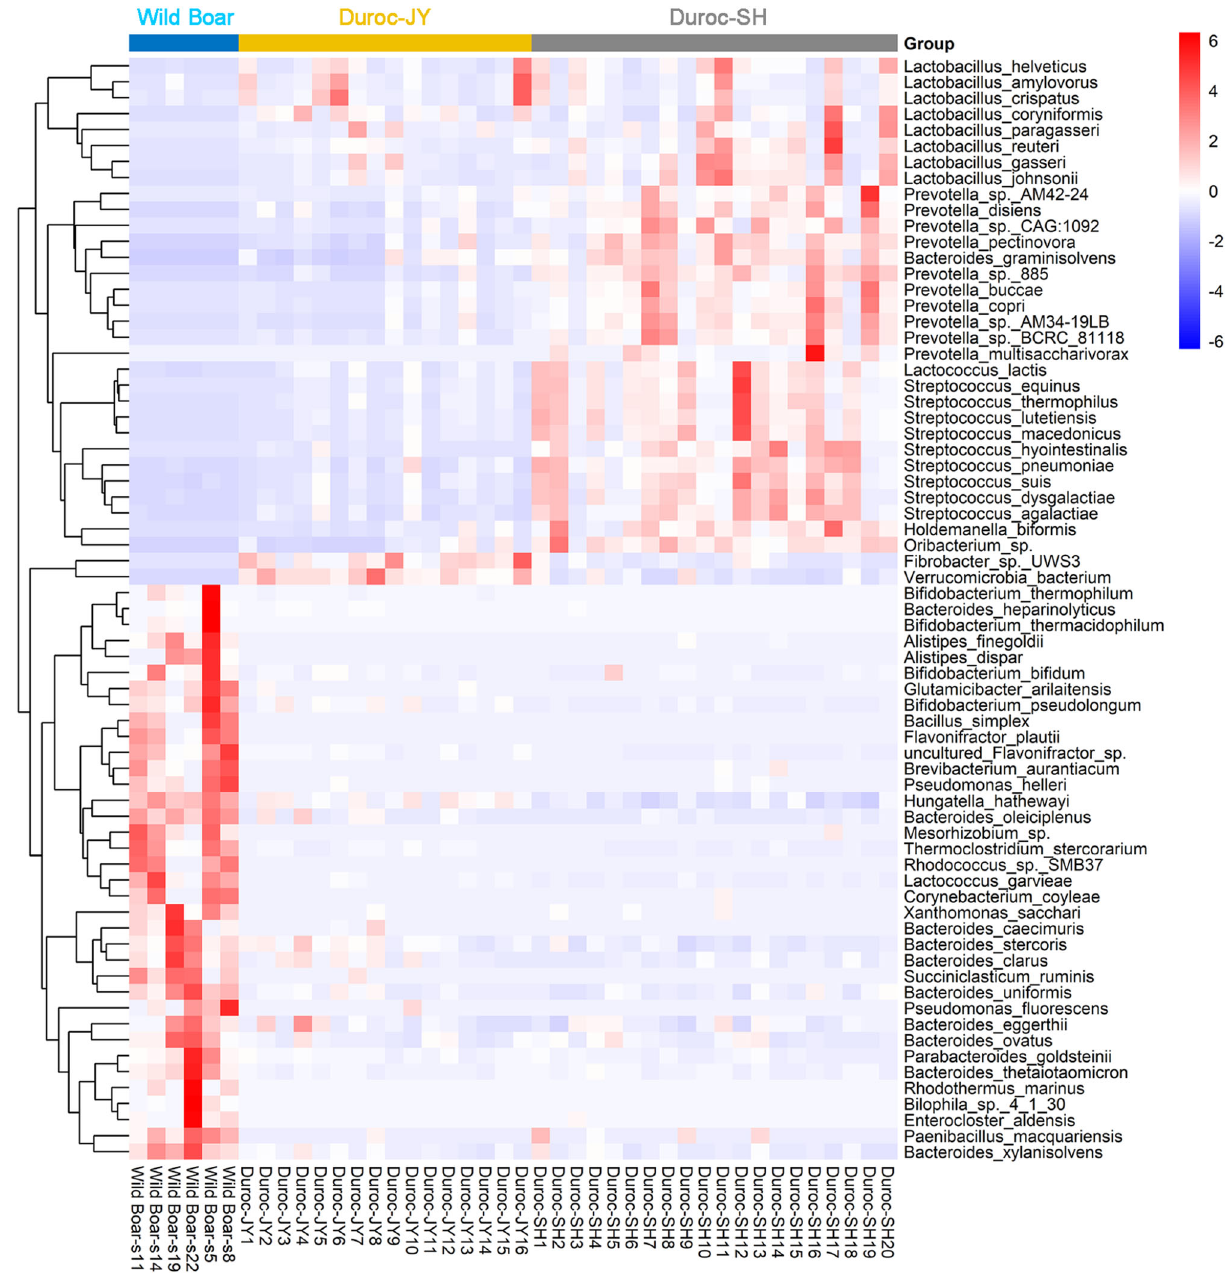
Fig. 5 Bacterial species enriched in wild boars and commercial Duroc pigs, respectively. Heatmap showed the parts of bacterial species enriched in wild boars and both two Duroc populations (Duroc-JY and Duroc-SH), respectively, at the signi fi cance threshold of Bonferroni-corrected P- value <0.01. All 180 signi fi cant bacteria species are listed in Supplementary Data